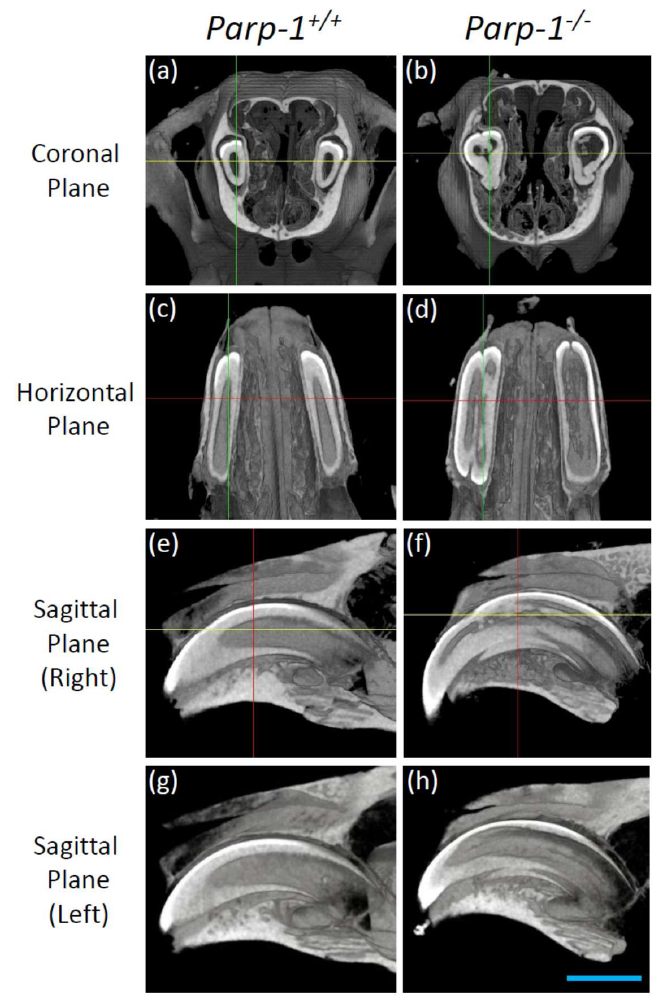
Figure 3. Representative CT images of incisors of aged Parp-1 +/+ and Parp-1 − / − mice (C57BL / 6). Mice incisors were analyzed from the coronal, horizontal, and sagittal plane, respectively. ( a ) Coronal plane of Parp-1 +/+ mouse. ( b ) Coronal plane of Parp-1 − / − mouse. ( c ) Horizontal plane of Parp-1 +/+ mouse. ( d ) Horizontal plane of Parp-1 − / − mouse. ( e ) Sagittal plane of right incisor of Parp-1 +/+ mouse. ( f ) Sagittal plane of right incisor of Parp-1 − / − mouse. ( g ) Sagittal plane of left incisor of Parp-1 +/+ mouse. ( h ) Sagittal plane of left incisor of Parp-1 −/− mouse. Bar indicates 2 mm.